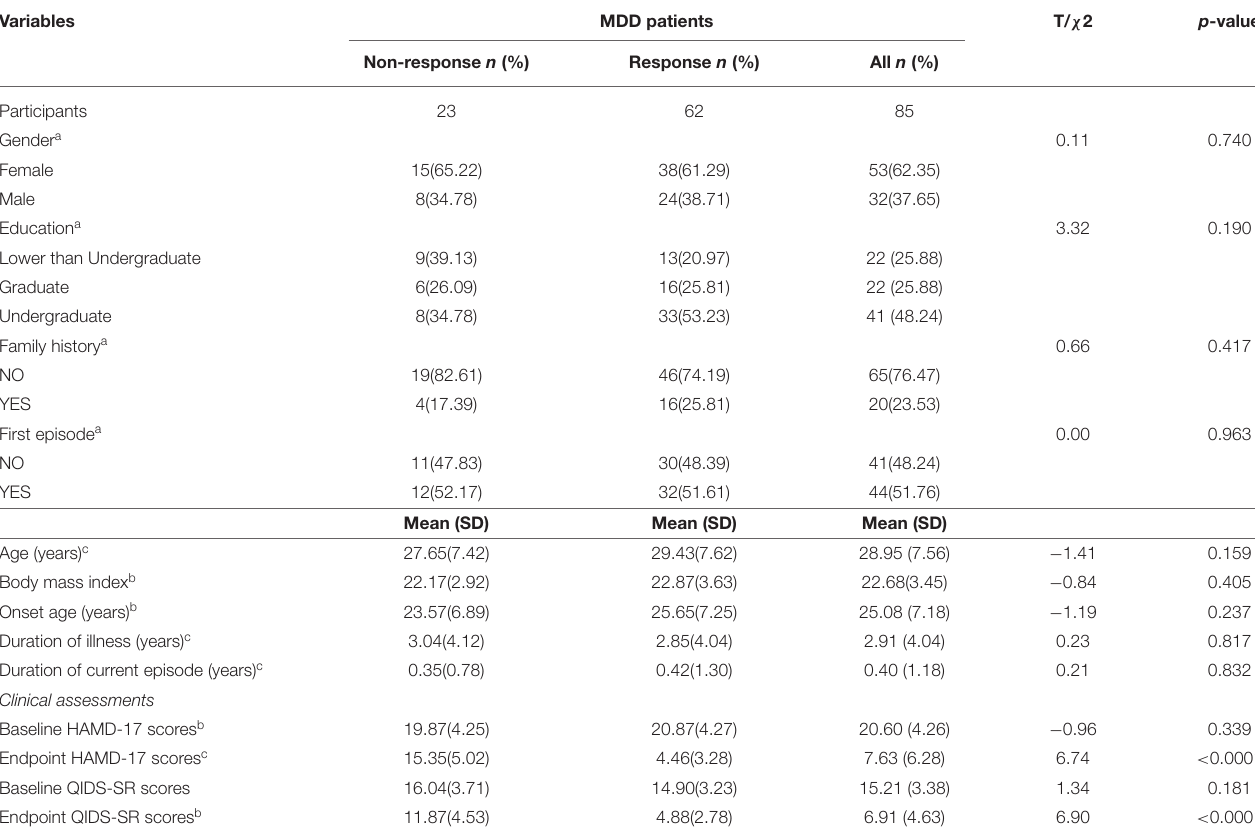
TABLE 1 | Demographic and clinical